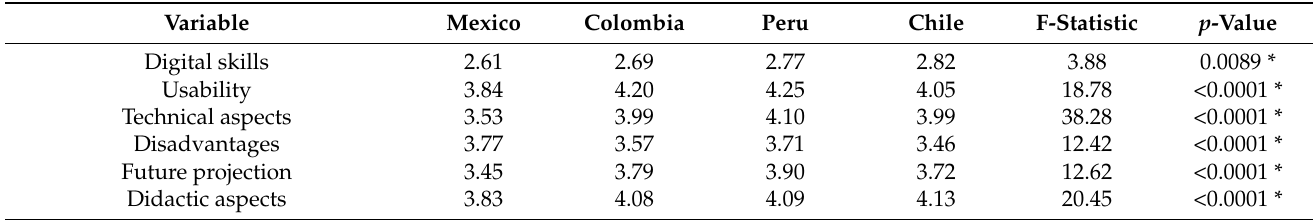
Table 4. Mean of the responses differentiating by country and Welch F-test statistics, without assuming equality of variances.